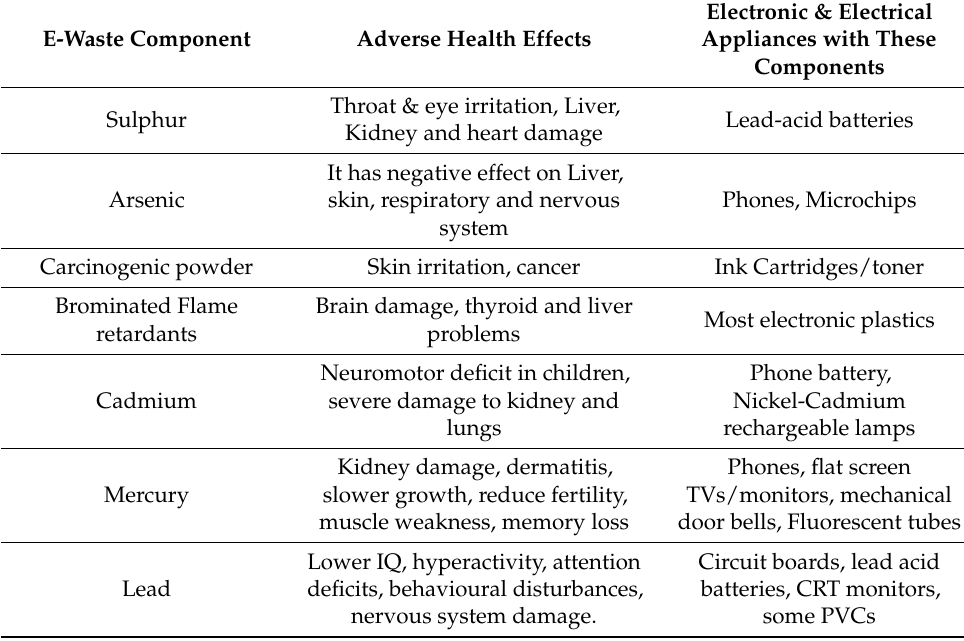
Table 3. Typical WEEE components and their adverse health